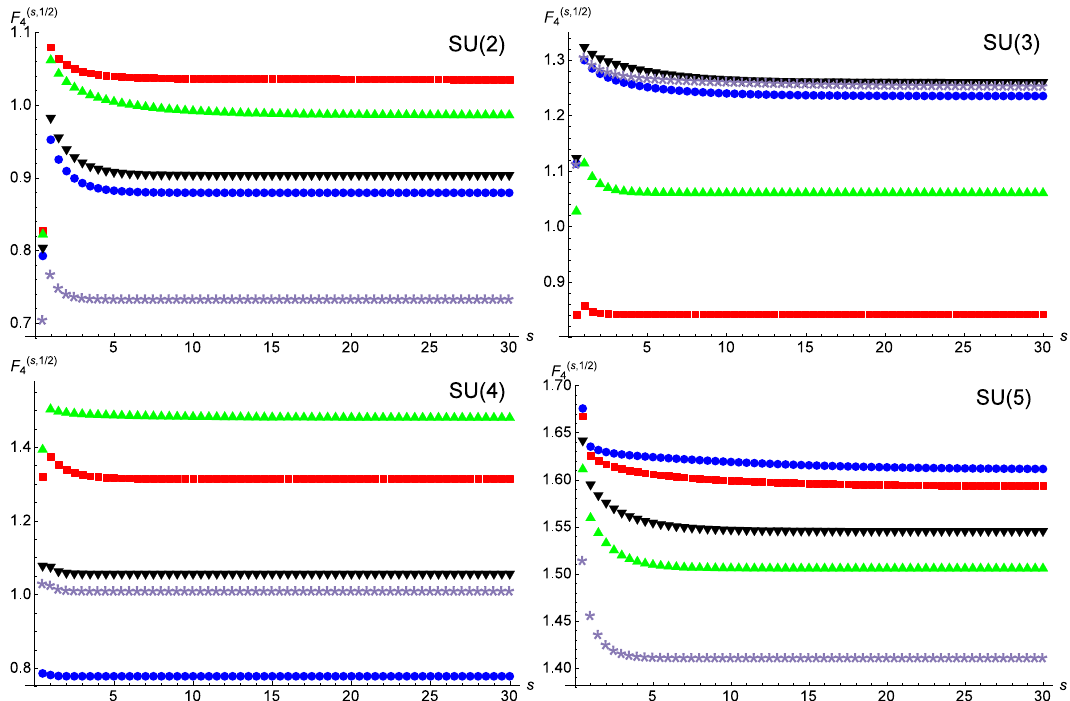
( (cid:28) ) for the spin-0 leading twist op- Figure 19 . s -dependence of the interpolating function F ( s; 1 = 2) 4 erator at randomly chosen (cid:12)ve points (cid:28) = ( r 1 ; (cid:1) (cid:1) (cid:1) ; r 5 ). ( r 1 : blue circle, r 2 : red square, r 3 : green triangle, r 4 : black inverse triangle, r 5 : purple asterisk) [Left-Top] SU(2) case, ( r 1 ; r 2 ; r 3 ; r 4 ; r 5 ) ’ (0 : 3377 + 0 : 4745 i; 0 : 8231 + 0 : 9956 i; 0 : 5698 + 0 : 5929 i; 0 : 8193 + 0 : 7029 i; 0 : 7449 + 0 : 34278 i ). [Right- Top] SU(3) case, ( r 1 ; r 2 ; r 3 ; r 4 ; r 5 ) ’ (0 : 1185 + 0 : 8770 i; 0 : 1236 + 0 : 3748 i; 0 : 09718 + 0 : 6059 i; 0 : 6656 + [Right-Bottom] SU(5)